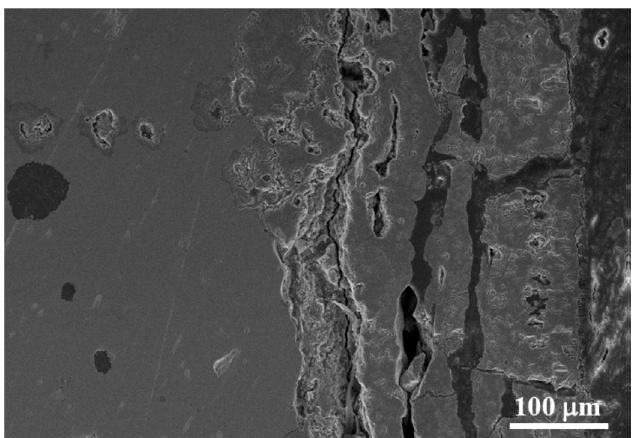
Figure 2. Mass gain of bare and aluminide-coated cast irons during cyclic oxidation at 850 °C.